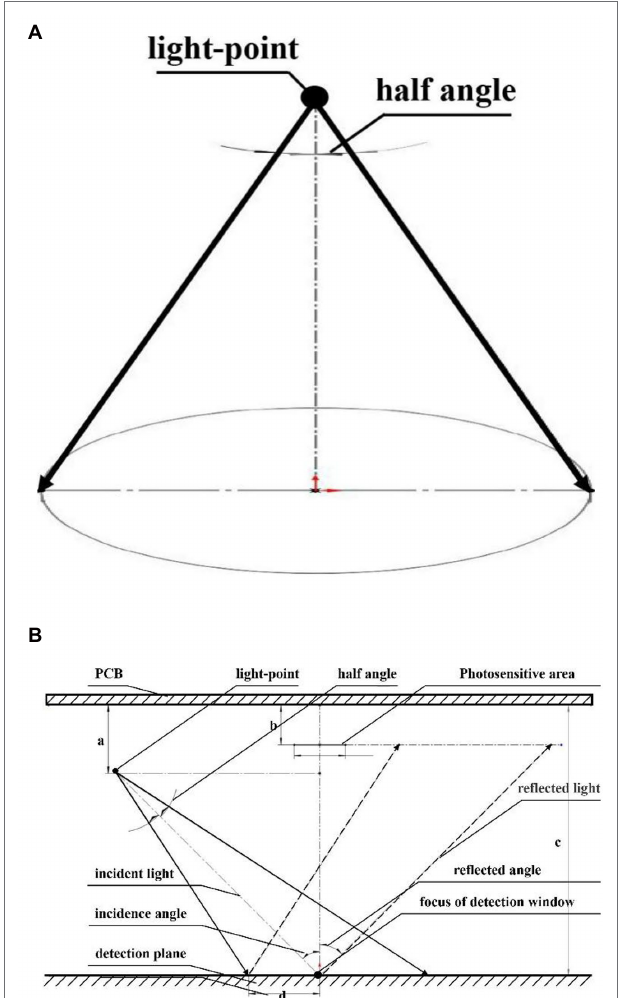
FIGURE 2 | The overall design of the NIR PSPMWG. 1. liquid crystal display (LCD) 2. battery 3. voice broadcast module 4. photoelectric detector 5. button 6. NIR LED 7. Fresnel lens 8. beam shaping diffusion film 9. detection window plane 10. sample pool.